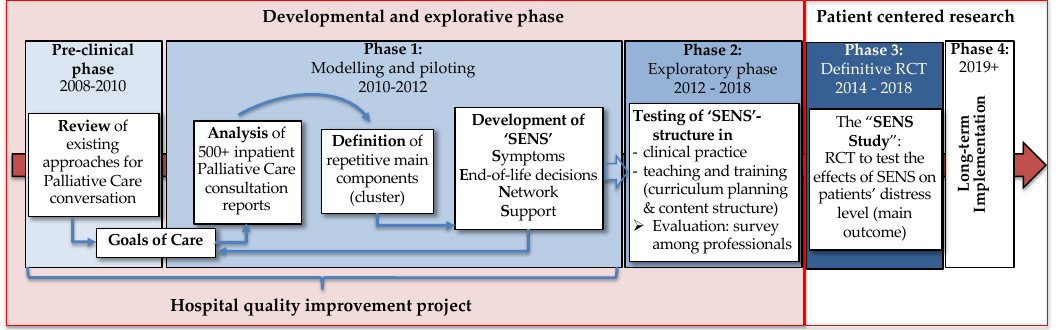
Figure 1 . Phases of developing the ’ SENS ‘ -structure based on the MRC framework (2000) Figure 1. Phases of development the ‘SENS’-structure based on the Medical Research Council (MRC) Figure 1. Phases of development the ‘SENS’ -structure based on the Medical Research Council (MRC) framework framework (2000).